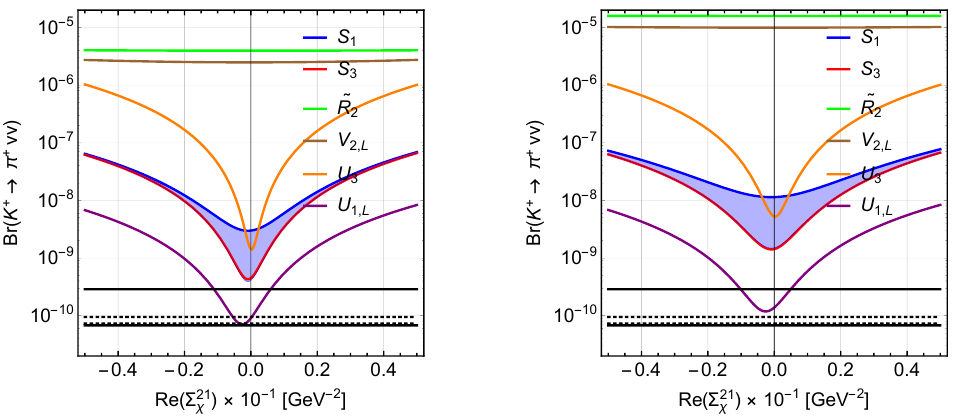
Figure 5. The dependence of B ( K + ! (cid:25) + (cid:23) (cid:22) (cid:23) ) on a non-zero real part of the dominant lepton- (cid:13)avour coupling, for (cid:20) " 0 = 0 : 5 [left] and (cid:20) " 0 = 1 : 0 [right], with (cid:22) (cid:3) = 20 TeV. Further shown are the current measurement of B ( K + ! (cid:25) + (cid:23) (cid:22) (cid:23) ) [73] [black solid] and the current SM predictions [21] [black